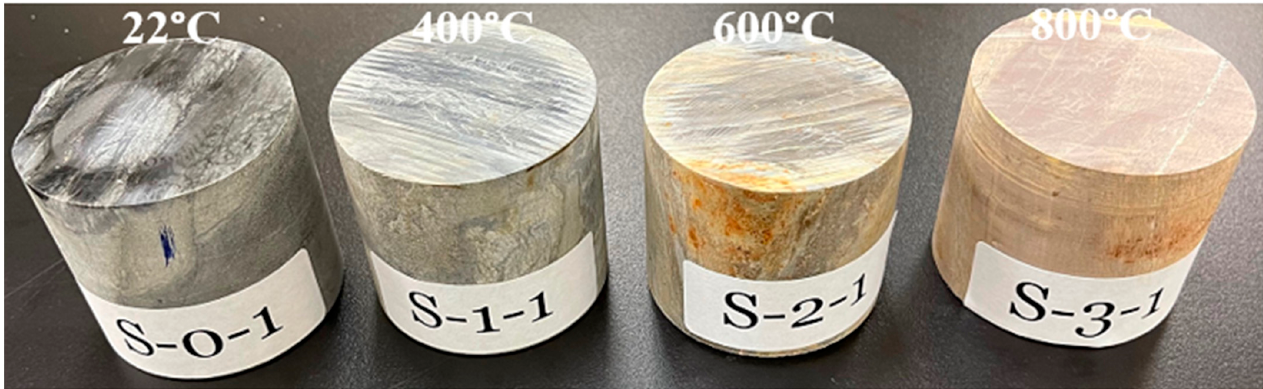
Figure 6. Effect of high temperature on microschist’s surface color (a sample is sellected from each studied set).